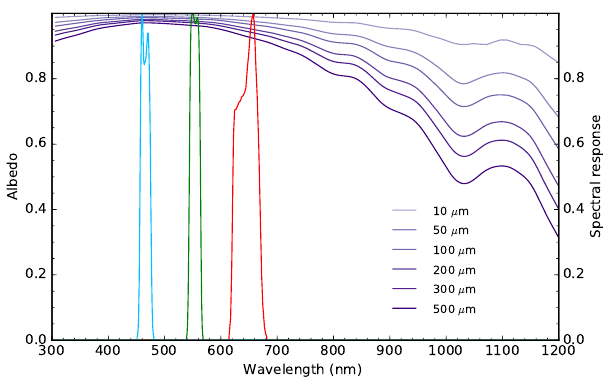
Figure 1. The pure-snow albedo as a function of wavelength for snow grain sizes between 10 and 500µm. Also shown in the thicker lines is the MODIS spectral response for band 3 (blue), 4 (green), and 1 (red). The spectral response data were obtained from http: